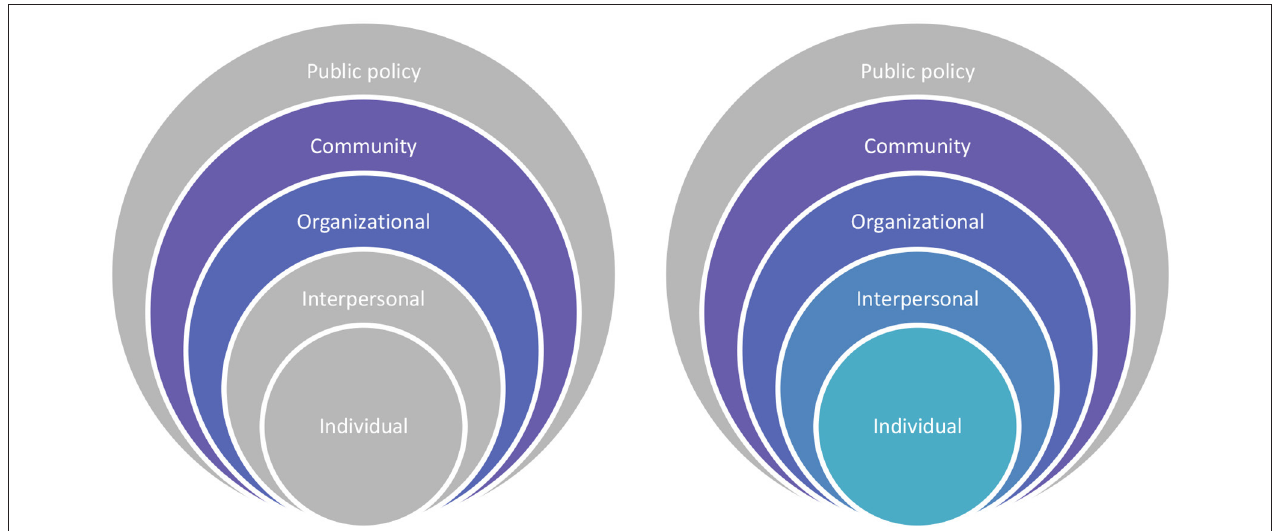
FIGURE 2 | Socio-ecological model and the levels covered by the policies (on the left, policies in Newcastle and on the right, policies in Amsterdam). Colored parts of the figure show the targeted levels and gray parts show the levels that are not (fully)